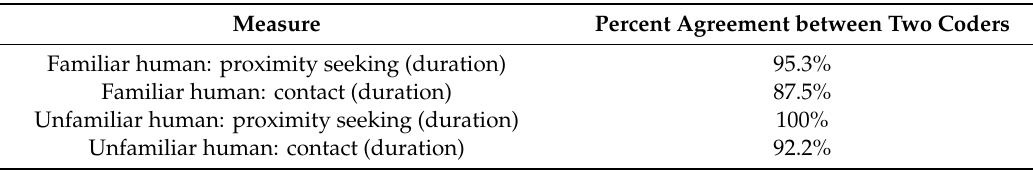
Table 3. Inter-rater reliability for all Paired Attachment